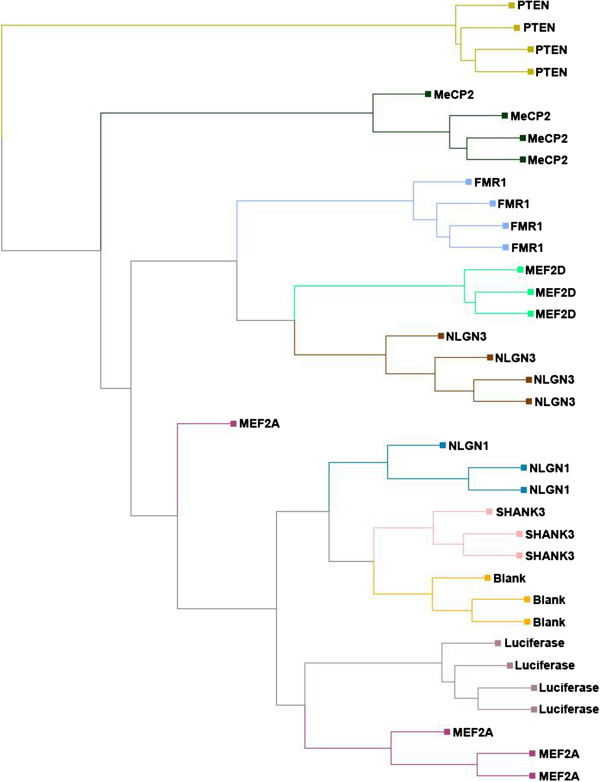
Hierachical clustering of intensity values from individual short-hairpin (sh)RNA knockdown experiments.